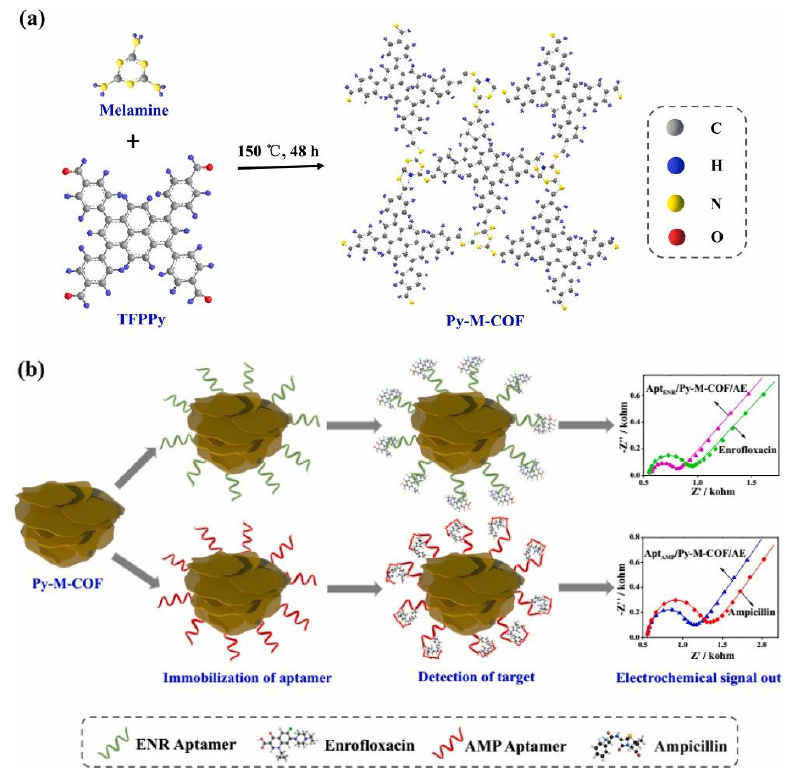
Figure 8. ( a ) Scheme of the synthesis of Py-M-COF . ( b ) Scheme of electrochemical detection of ENR and AMP using the Py-M-COF -based aptasensors. Reprinted with permission from Ref. [125]. Copyright 2019 Elsevier.